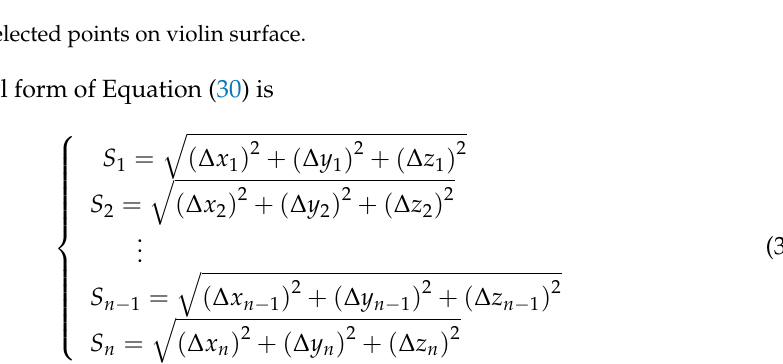
Figure 4. Multi-selected points on violin